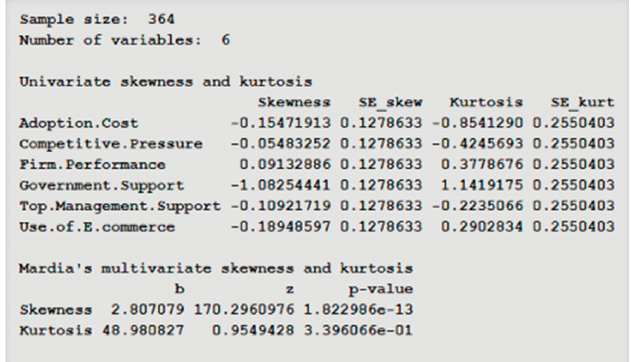
Figure 2. Mardia’s multivariate skewness and kurtosis.